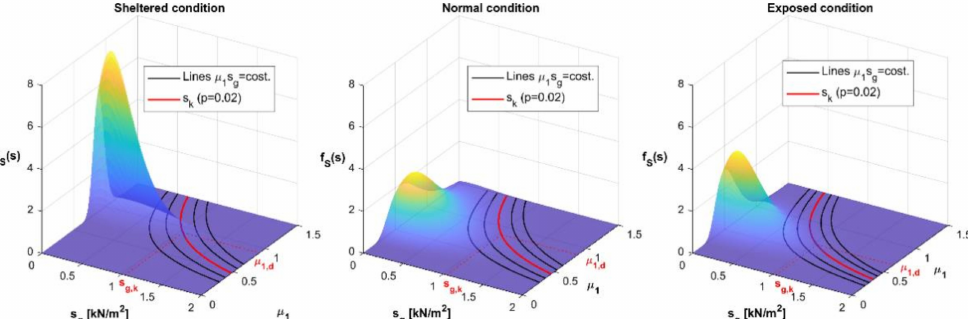
Figure 3. Joint probability density function ( pdf ) of ground snow load ( s g ) and shape coefficient ( µ 1 ) for flat roofs (Lodi weather station) under different exposure conditions (black curves represent a constant roof load ( s ), while the red curve corresponds to s = s k